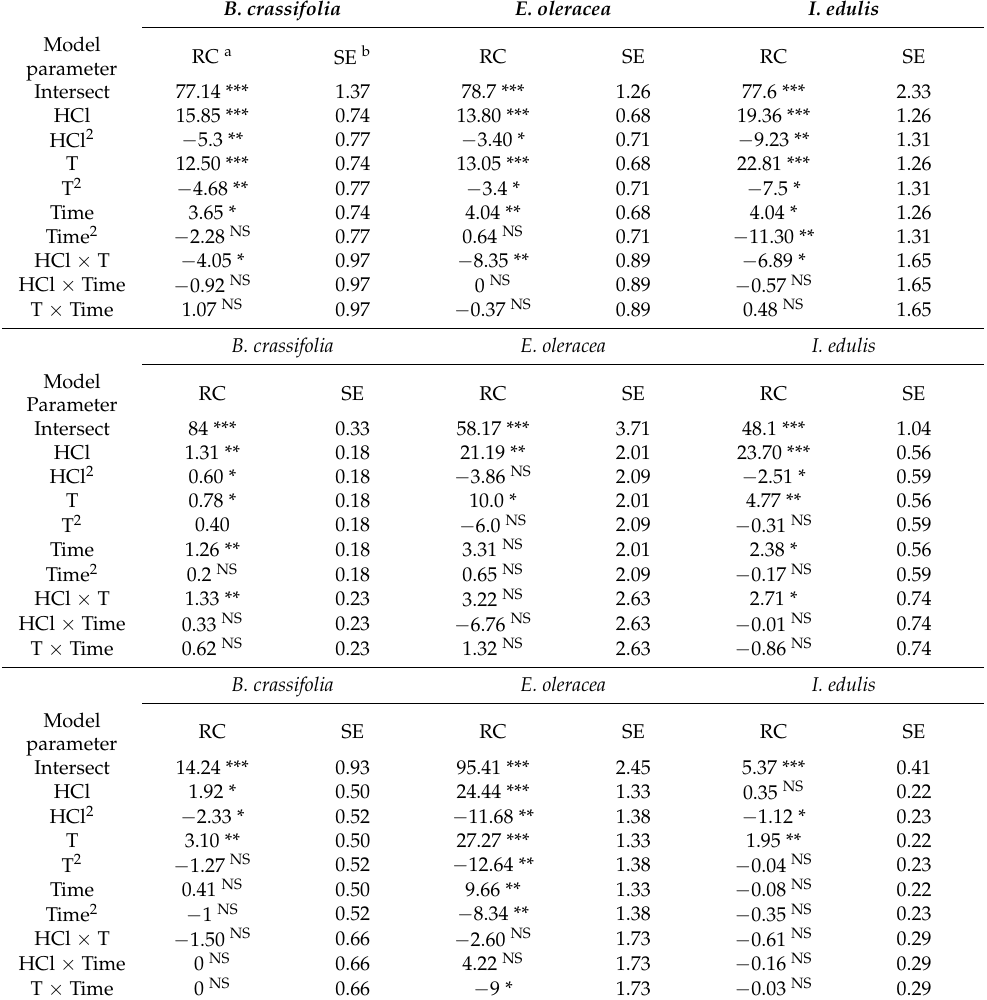
Table 4. Regression coefficients for the parameters of the second-order polynomial model for the response